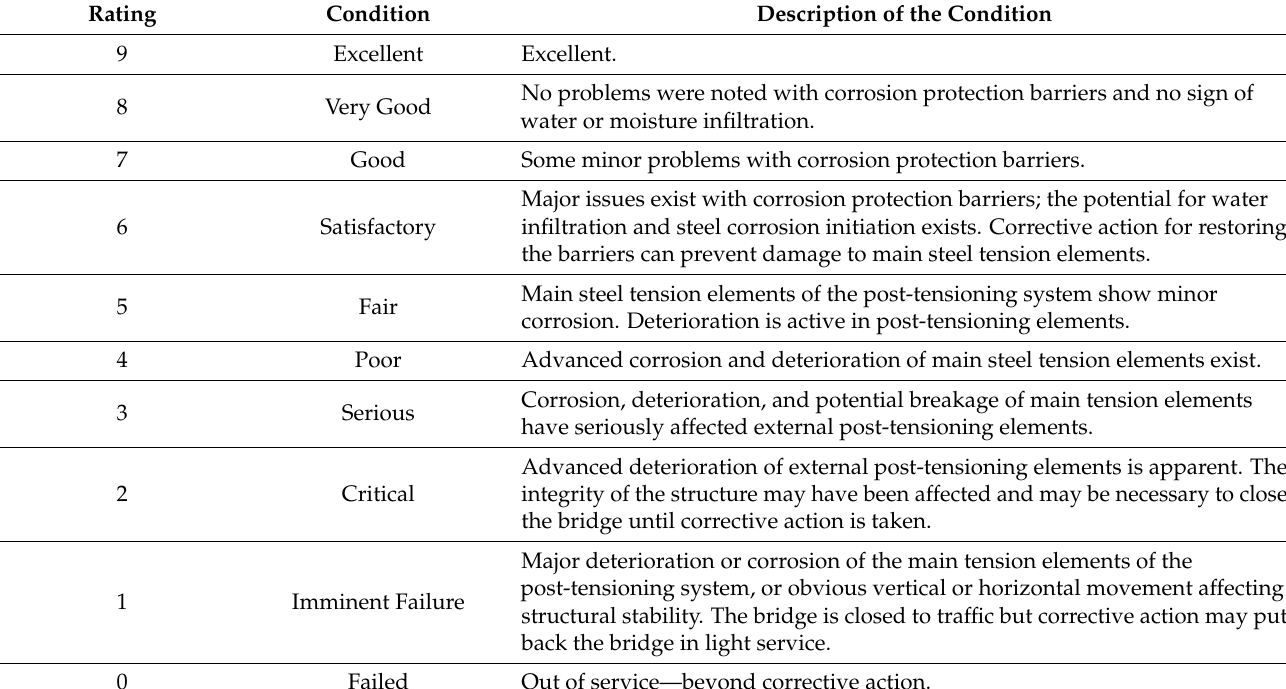
Table 1. Condition rating proposed for external post-tensioning tendons adapted based on SNBI